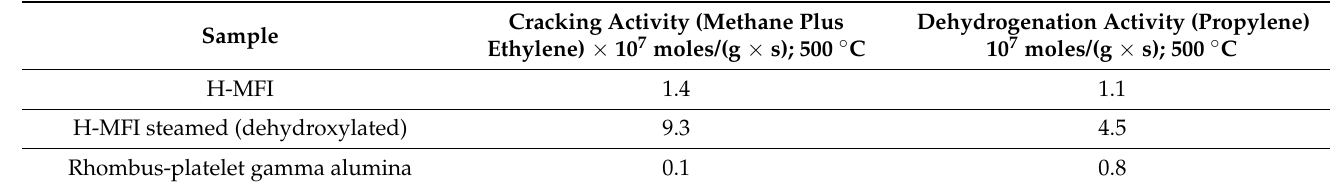
Table 1. Propane cracking and dehydrogenation activity over H-MFI, steamed H-MFI, and γ -Al 2 O 3 . WHSV ~20 h − 1 . Note that cracking produces methane and ethylene, whereas dehydrogenation produces propylene.